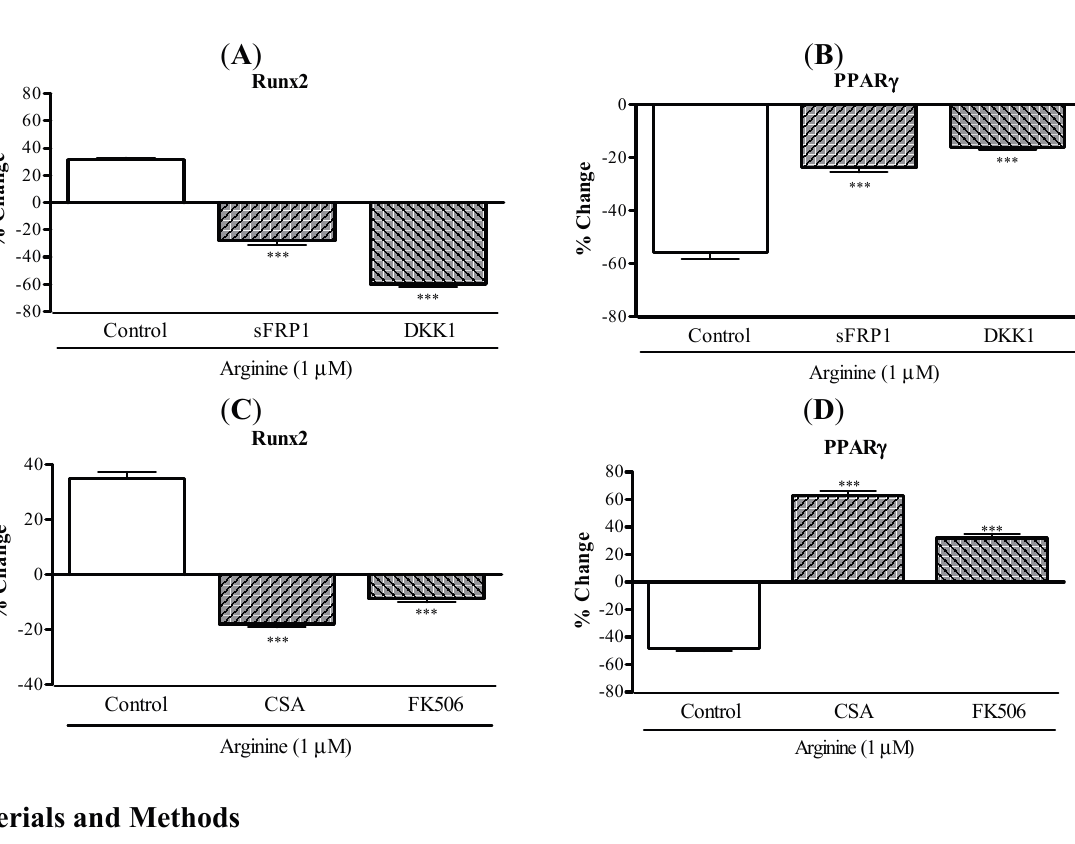
Figure 5. Role of Wnt and NFATc signaling in arginine induced osteoblastic and adipogenic differentiation in MSCs. ( A , B ) MSCs were treated with 1 μ M arginine in the presence of the Wnt inhibitors sFRP1 (250 ng/mL) and DKK1 (50 ng/mL) and then the expression of Runx2 and PPAR γ mRNAs was analyzed using qRT-PCR; ( C , D ) MSCs were treated with 1 μ M arginine in the presence of calcineurin inhibitors CSA (100 ng/mL) and FK506 (50 ng/mL) and then changes in the expression of Runx2 and PPAR γ mRNAs were determined by means of qRT-PCR analysis. The results are representative of two experiments, and each bar represents the mean ± S.E.M. *** p < 0.001 compared with control (cells were treated with 1 μ M